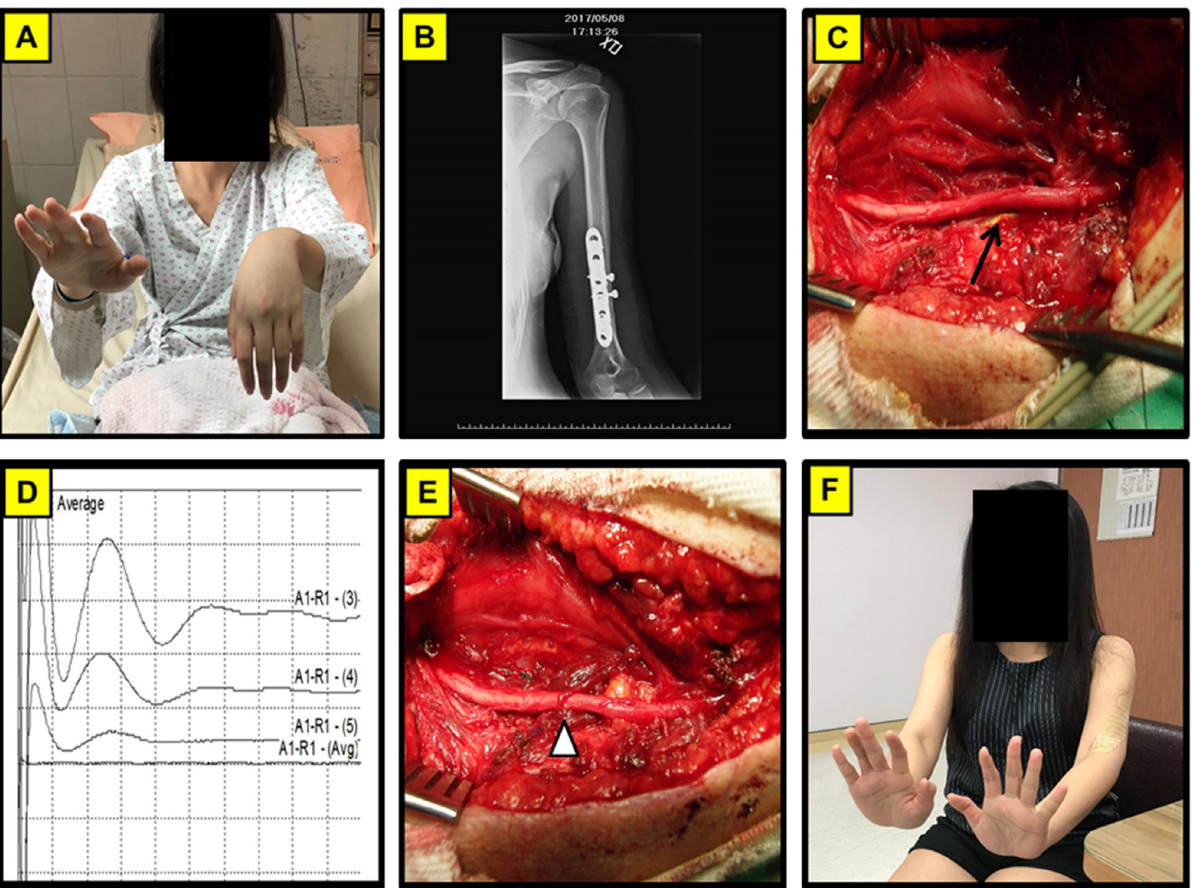
Fig 3. Representative left humerus fracture after ORIF complicated with nerve entrapped by the implant. (A) A 27-year-old female presented with left wrist drop for 6 months after a humerus fracture s/p operation repair of the fracture. (B) Plate and screws fixation in left humerus on X- ray film. (C) The photography showed the left radial nerve entrapped by the implant. (D) Intraoperative recording of CMAP stimulated from the distal to proximal end of nerve. (E) Rotation of a muscle flap to wrap the injured region and separation of the radial nerve from the implants. (F) The patient showed favorable neurological outcome with restoration of wrist function 3 months after operation. Arrow: implant; Arrow head: Muscles flap to wrap the radial nerve and separate it from the implant.